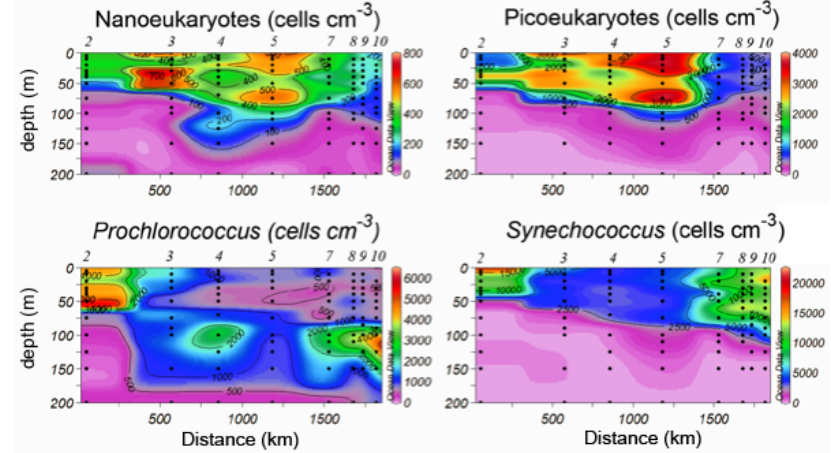
Fig. 12. Vertical distribution of ultraphytoplankton along the transect defined by stations 2 to 10, namely nanoeukaryotes, picoeukaryotes, Prochlorococcus and Synechococcus . Note that station 5 (Sicily Strait) delimits a clear transition for all distributions between the western and eastern Mediterranean basins.